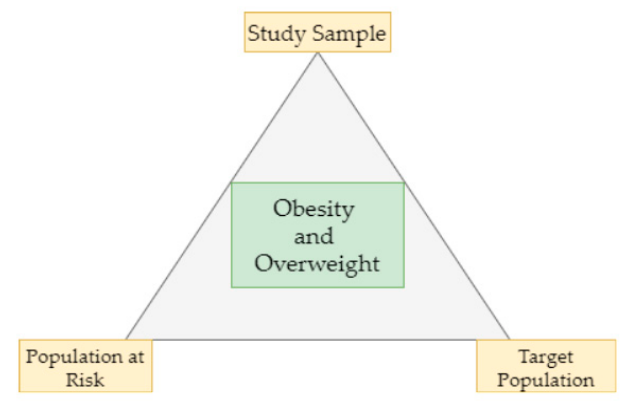
Figure 2. The focused epidemiological study triangle [33].